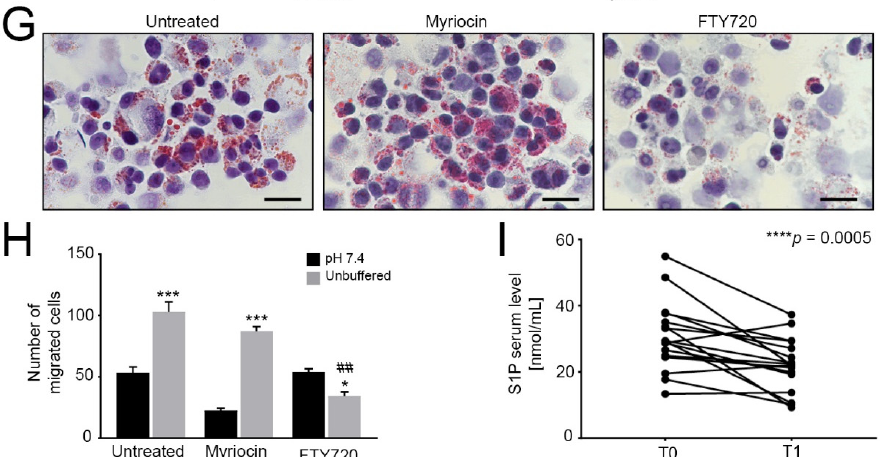
Figure 3. Lipidomic profiling reveals an increased sphingolipid signaling pathway. When indicated, cells were treated with myriocin at 0.75 µ M or/and FTY720 at 0.15 µ M. A-B. Principal component analysis of spheroids grown for 96 h under neutral or unbuffered conditions ( A ) and quantification of sphingomyelin (middle panel) and phosphocholine (right panel) in the lipidomics dataset ( B ). Data presented as mean ± S.E.M.; n = 5; unpaired t -test; *** p < 0.001; ( C ) Schematic representation of the sphingomyelin pathway; ( D ) Real Time PCR analysis of the indicated genes normalized to 4 housekeeping genes (HKG; GAPDH, GUSB, RNA18S, and YWAHZ) in 143B spheroids cultured for 96 h treated myriocin or FTY720. Data presented as mean ± S.E.M. of n = 6 RNA samples from 3 independent experiments; unpaired two-tailed Mann-Whitney test; * p < 0.05 for acid vs neutral; ( E ) S1P levels in 143B spheroids cultured for 96 h treated with myriocin or FTY720 were determined by ELISA. Data presented as mean ± S.E.M. of n = 6 samples from 3 independent experiments; unpaired t -test; ** p < 0.01 for acid versus neutral, ### p < 0.0001 vs untreated at the respective pH condition; ( F ) Number of 143B cells grown in spheroids under unbuffered or neutral conditions after 96 h of treatment with myriocin or FTY720. Data presented as mean ± S.E.M.; n = 4; unpaired t -test; *** p < 0.001 vs. neutral untreated, # p < 0.05 and ## p < 0.01 vs unbuffered untreated; ( G ) Oil Red O staining of cultured hanging-drop 143B spheroids treated as indicated and exposed to unbuffered medium for 96 h. Scale bar: 100 µ m; ( H ) Migration of 143B spheroids treated as indicated. After 96 h of treatment, the spheroids were dissociated with trypsin, and the cells were allowed to migrate for 6 h in a Boyden chamber. The graph shows the quantification of cell migration. Data presented as mean ± S.E.M. of n = 6 samples from 3 independent experiments; unpaired two-tailed Mann-Whitney test; ## p < 0.01 vs untreated at the respective pH, * p < 0.05 and *** p < 0.0001 for unbuffered vs neutral; ( I ) Serum S1P levels in OS patients were determined by ELISA at the time of diagnosis (T0) and after chemotherapy (T1). n = 17 patients; Wilcoxon matched-paired test; *** p <